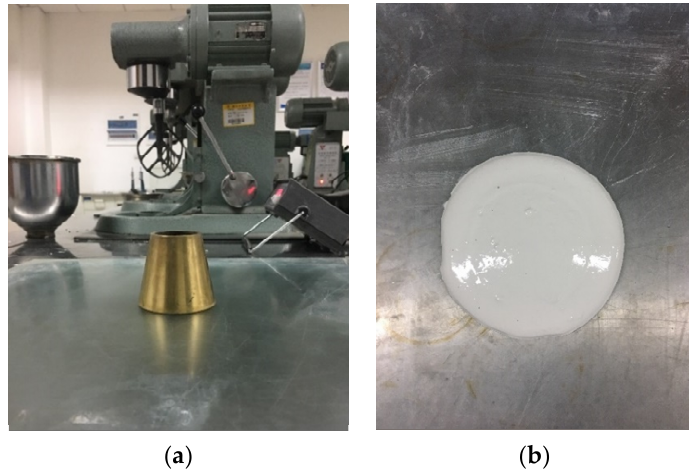
Figure 3. Fluidity testing of the fresh cement paste. ( a ) The mold used and ( b ) the paste spread.